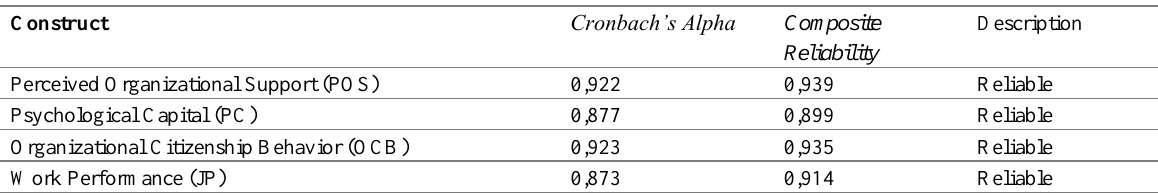
Table 3: Composite